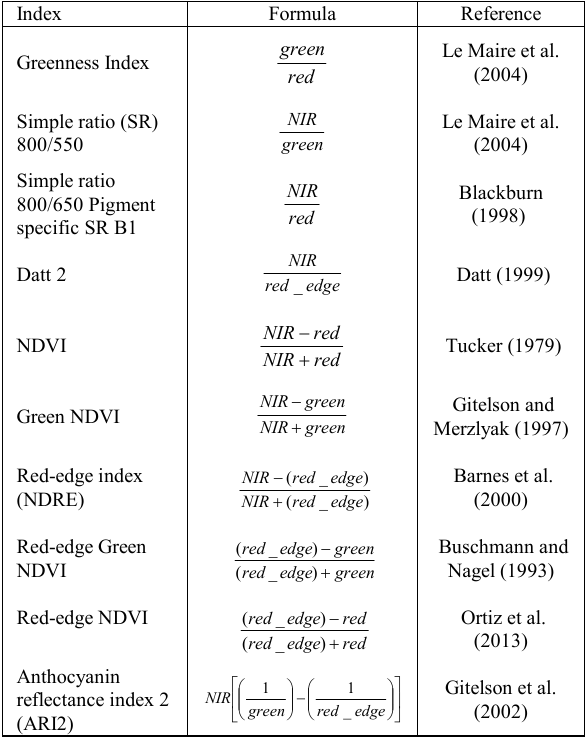
Table 1. Summary of selected vegetation indices used for tree stress detection caused by bark beetle infestation, where green is band 1 (550 nm), red is band 2 (650 nm), red_edge is band 3 (700nm) and NIR is band 4 (800